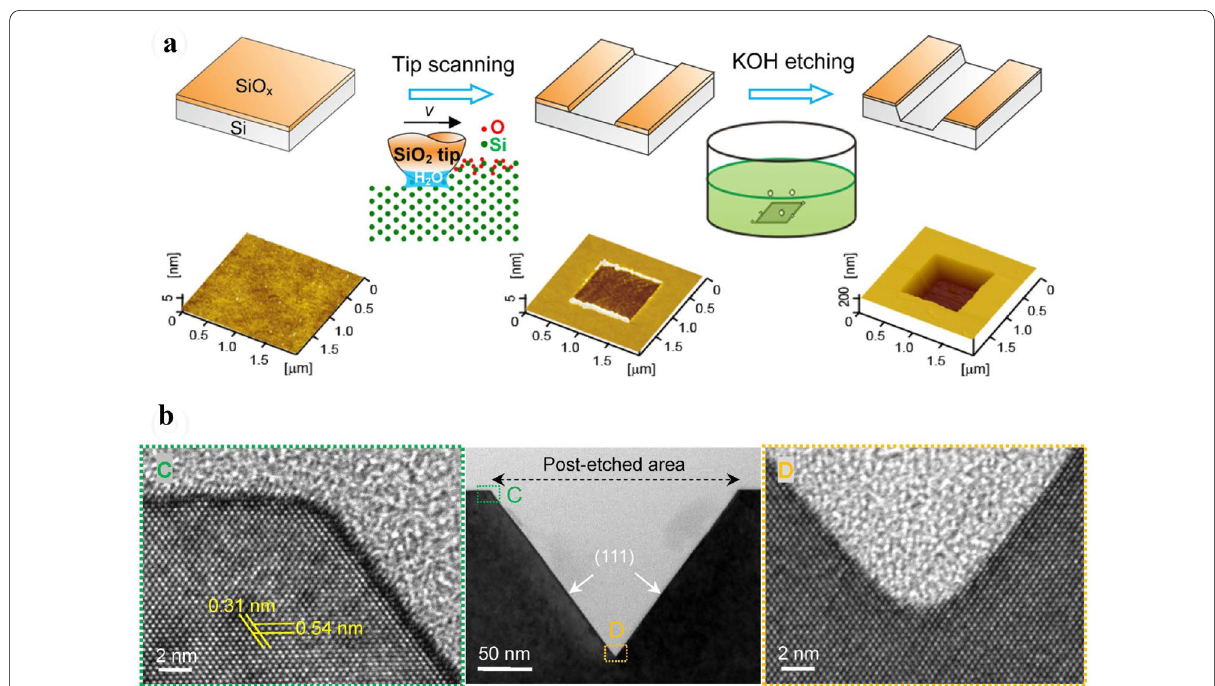
Figure 19 Defect-free nanofabrication by tribochemistry-induced selective etching [75]: ( a ) Fabrication process of tribochemistry-induced selective etching on silicon surface, ( b ) HRTEM observation of a defect-free groove with two magnified images on side